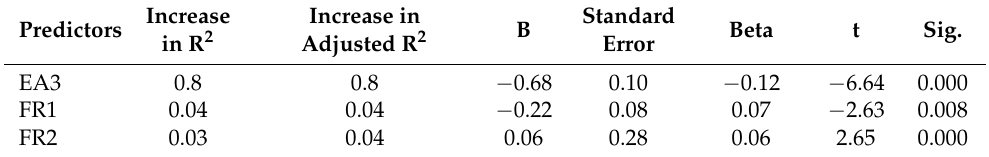
Table 5. Multiple regression